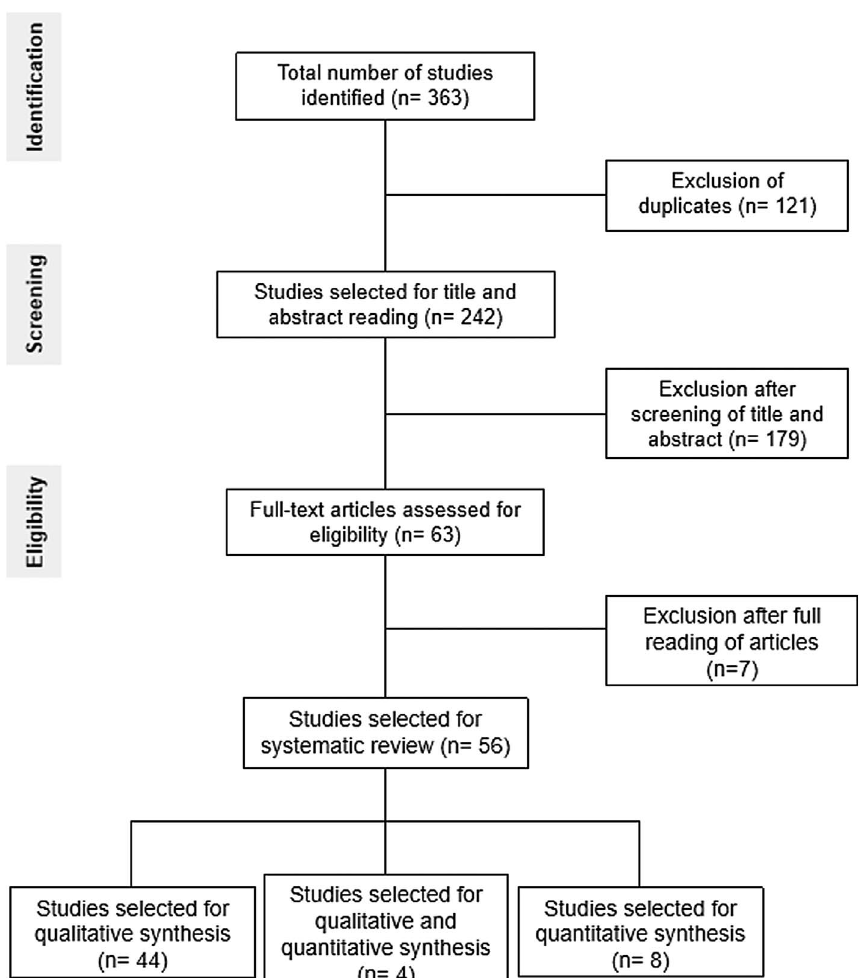
Figure 1. Flow chart of the search, selection and inclusion process for studies in the systematic review based on PRISMA